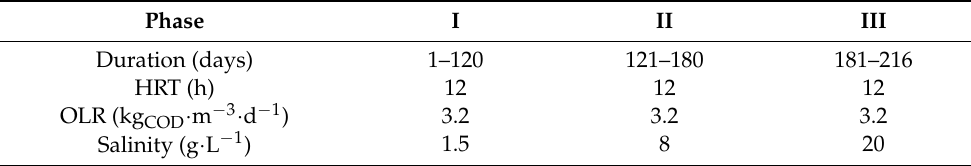
Table 2. Bioreactors operation during the